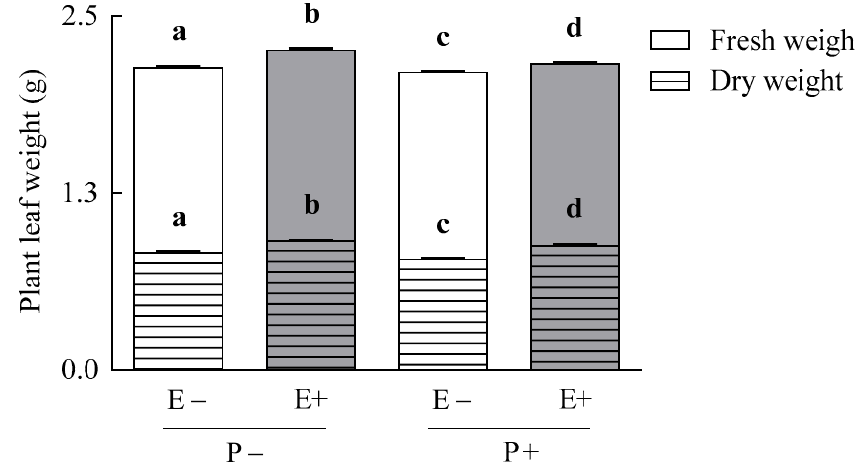
Figure 3. Plant leaf fresh (plain bars) and dry (stripped bars) weights of Achnatherum inebrians plants with (E+, shaded bars) and without (E − , unshaded bars) the fungal endophyte Epichloë gansuensis and inoculated (P+) and non-inoculated (P − ) with the pathogen Blumeria graminis . Plant weights were measured at three weeks after the pathogen inoculation of plants. Different letters indicate significant differences at p < 0.05. Bars represent means values ± SEM ( n = 9).